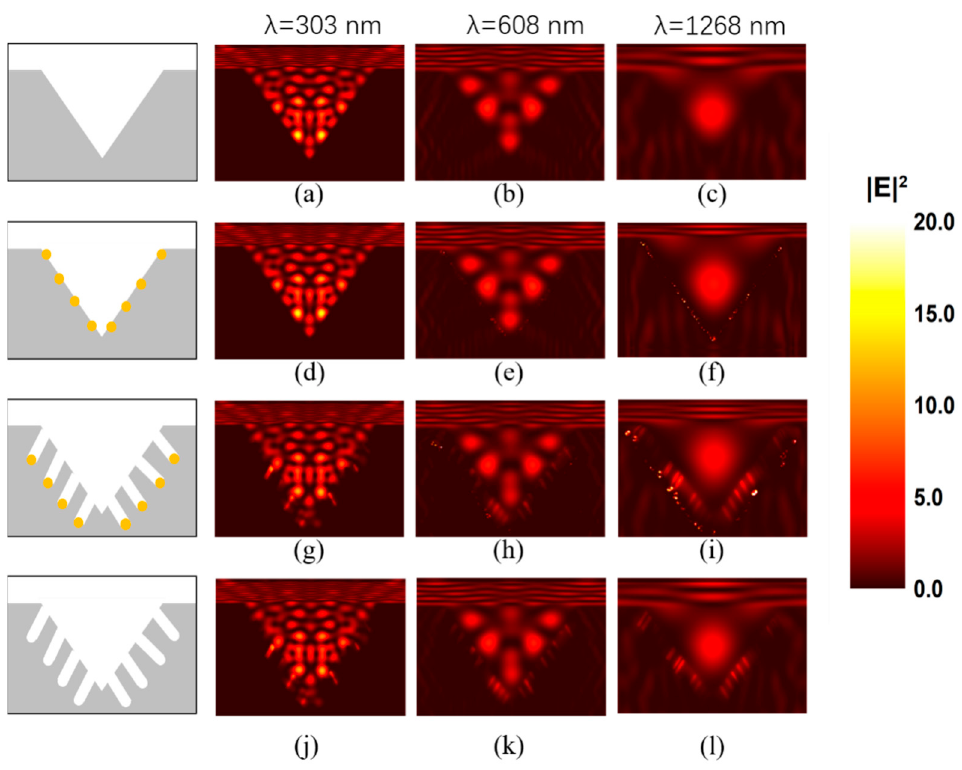
Figure 6. FDTD simulation of λ = 303, 608, 1268 nm with corresponding morphologies. ( a – c ) Simulation of an inverted pyramid without AuNPs at λ = 303, 608, 1268 nm; ( d – f ) Simulation of an inverted pyramid with AuNPs at λ = 303, 608, 1268 nm; ( g – i ) Simulation of an inverted pyramid with nanoholes and AuNPs at λ = 303, 608, 1268 nm; ( j – l ) Simulation of an inverted pyramid with nanoholes but without AuNPs at λ = 303, 608, 1268 nm.